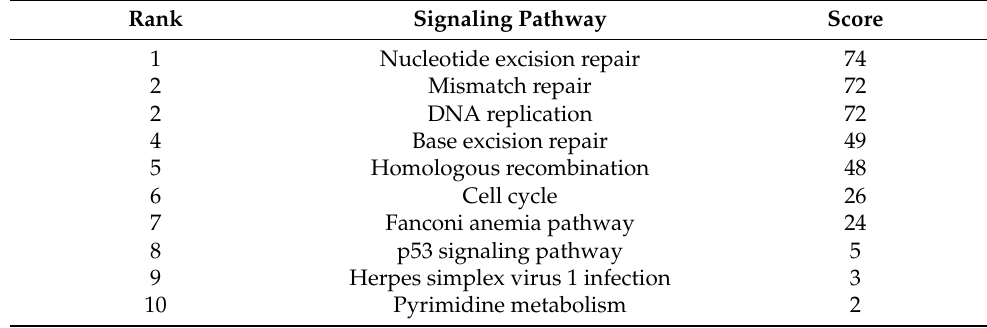
Table 3. Top 10 hub pathways of genes included in f and g ranked by MCC method. Rank Signaling Pathway